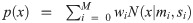
Distribution of the cold pain thresholds (CPT) observed in n = 329 subjects pooled from previous studies (Table 1).The graph displays the data after rescaling for stimulus intensity as SI = 32°C - CPT (Fig 1) and subsequent log transformation as LogSI = ln(SI+1). The density distribution is presented as probability density function (PDF), estimated by means of the Pareto Density Estimation (PDE [21]). A Gaussian mixture model (Eq 1; GMM given as px = ∑i = 0MwiN(x|mi,si)), was fit to the data, for which the optimum number of mixes was found to be M = 3. Subject distribution among the obtained three Gaussians was n = 155, n = 61 and n = 113 for Gaussian 1–3, respectively, starting from the left.